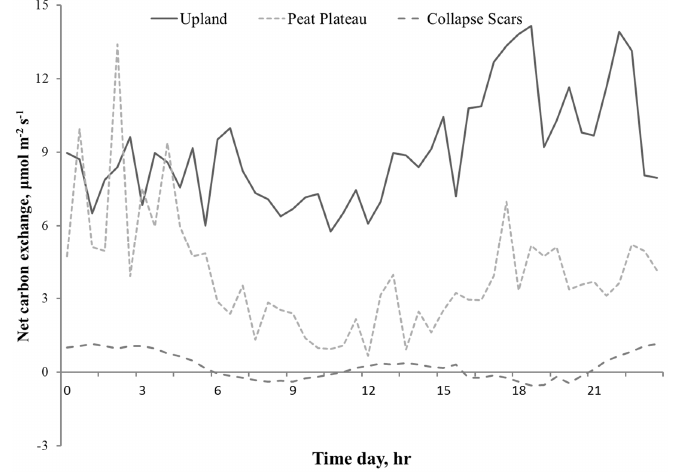
Figure 4. Role of landform on diurnal variation in NCE in upland, peat plateau, and collapse scar on 25 June 2009, at Fort Simpson (NWT) Canada.